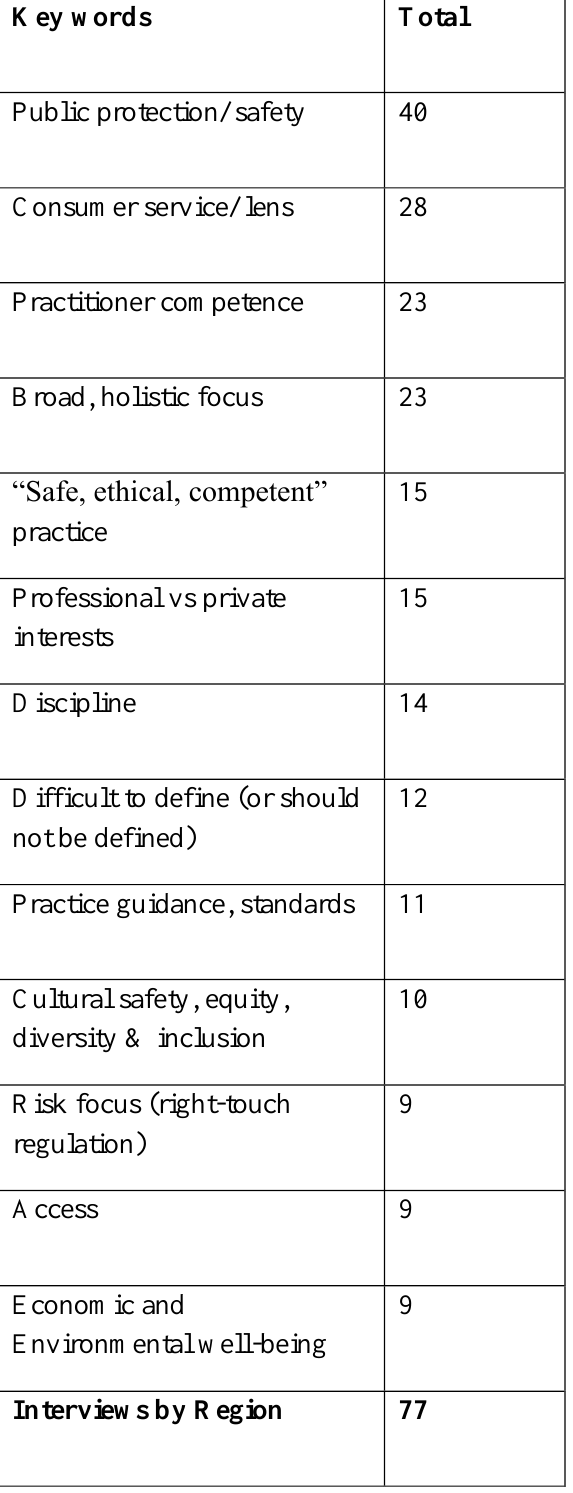
Table 1. Meanings attached to the public interest by participants, number of mentions. Key